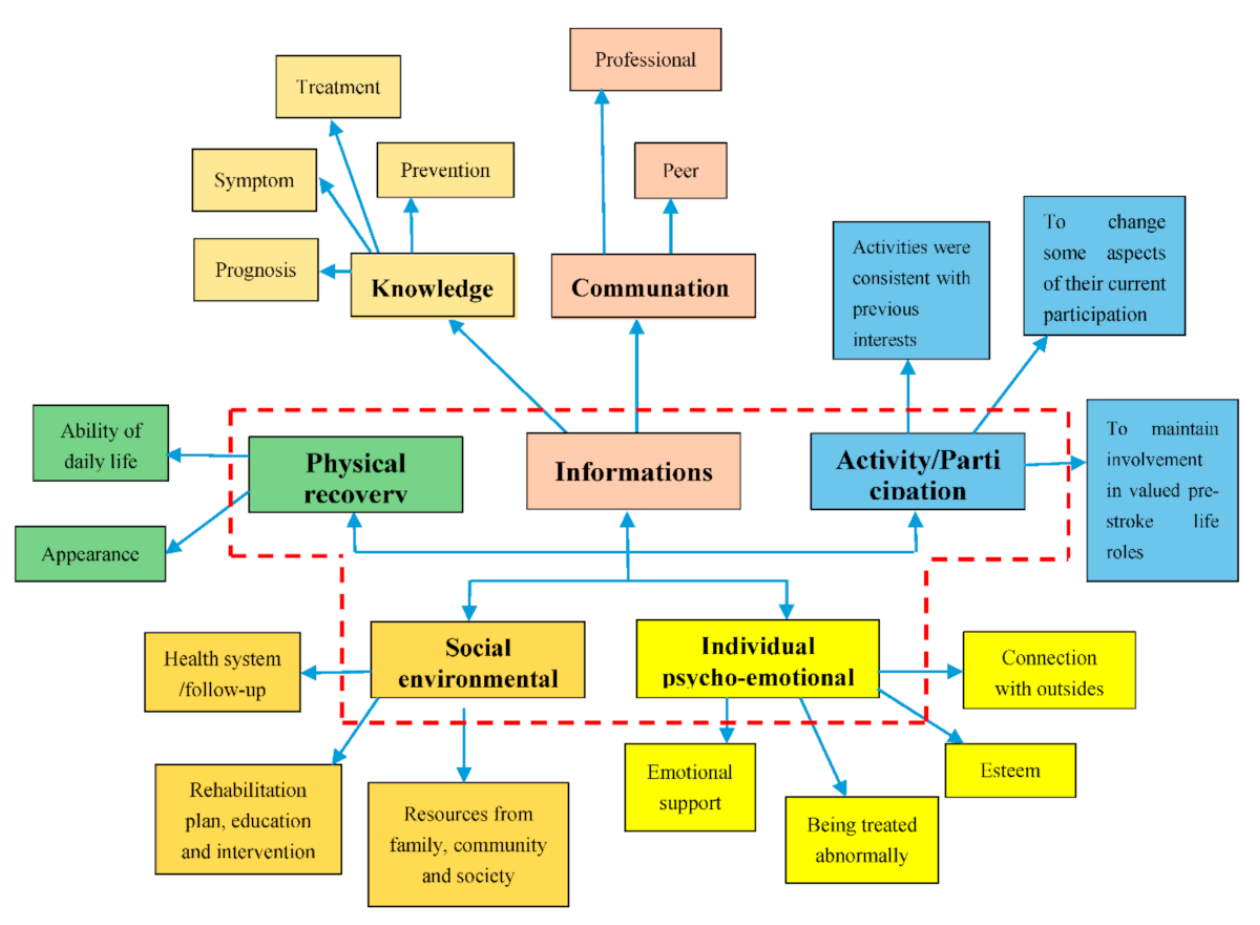
Figure 2. Coding